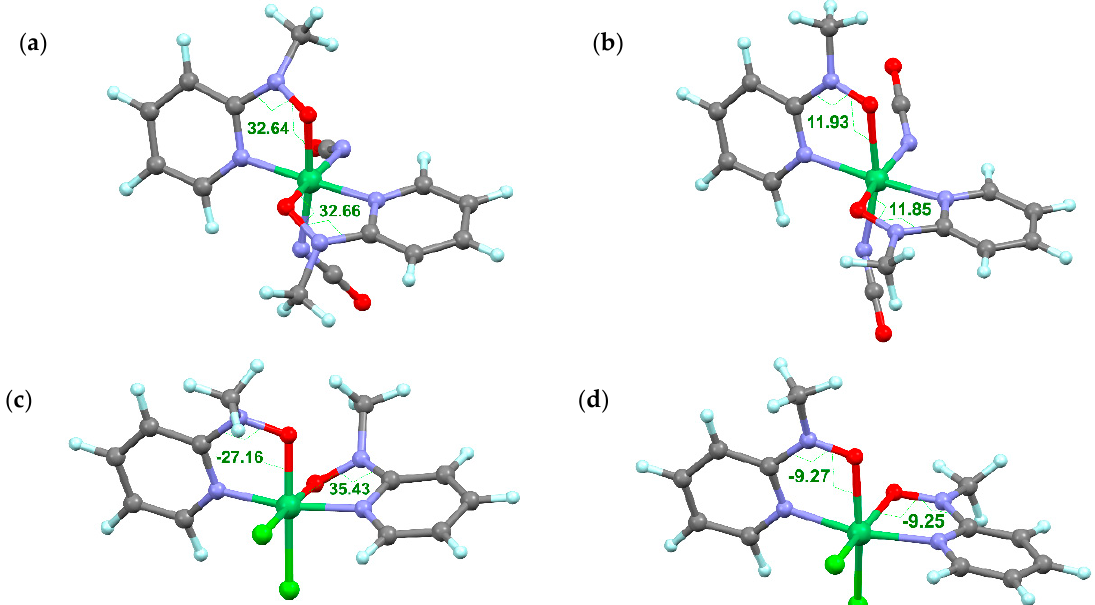
Figure 12. Optimized structures of 2p–3d–2p model compounds: [NiL’ 2 (NCO) 2 ] in the diamagnetic state ( a ) and the S total = 2 state ( b ) and [NiL’ 2 Cl 2 ] in the diamagnetic state ( c ) and the S total = 2 state ( d ), where L’ stands for methyl 2-pyridyl nitroxide. The Ni–O–N–C sp2 torsion angles are indicated. Color codes: Ni, green; C, black; H, turquoise; N, blue; O, red; Cl, light green. Adapted from [122], published by MDPI, 2020.